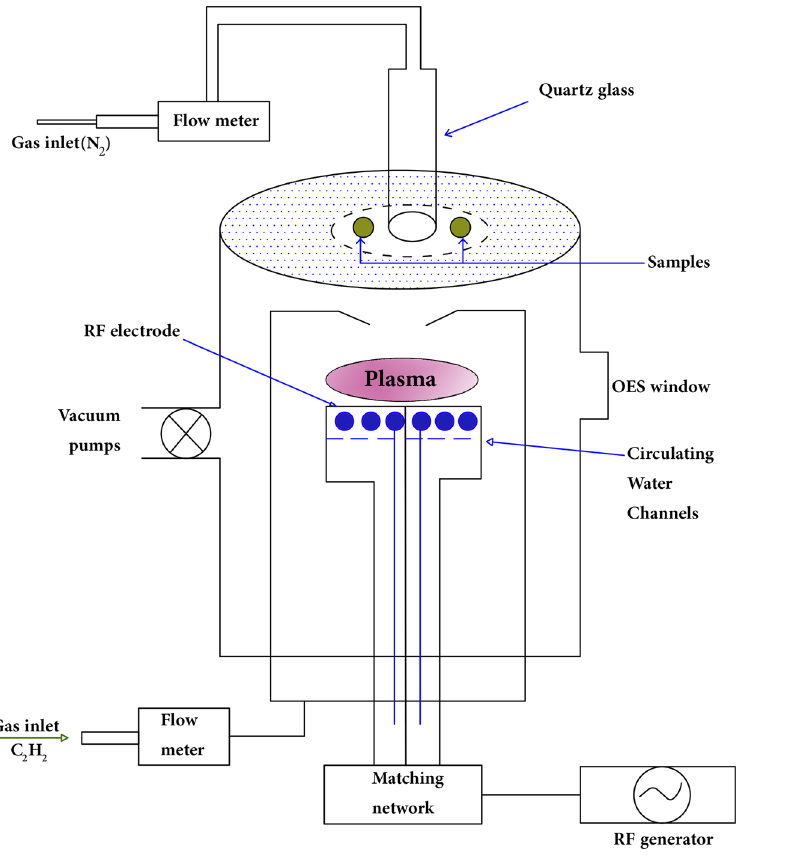
Figure 13. A schematic diagram of plasma polymerization